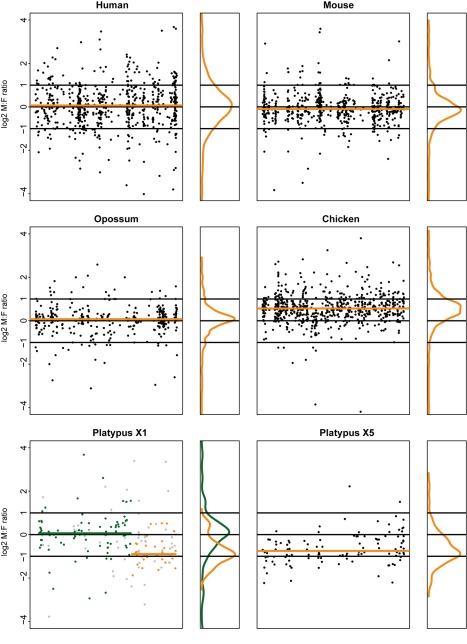
Male versus female expression levels of individual sex chromosomal genes in cerebellum from representative amniotes.Male to female (M∶F) gene expression ratios are plotted for individual genes (expressed in both sexes) on the human, mouse, and opossum X, platypus X1 and X5, and chicken Z chromosome for a representative tissue (cerebellum). Values are plotted on a log2 scale to allow for linear and symmetrical patterns (e.g., 0.5 [log2 ratio of −1]; 1 [log2 ratio of 0]; and 2 [log2 ratio of 1]). Median M∶F ratios for human, mouse, and opossum X, platypus X5 and X1 non-pseudoautosomal region, and chicken Z are indicated by orange lines. The distribution of individual M∶F ratios (orange vertical plots) is shown to the right of each main plot. Expression ratios of individual genes on the platypus X1 chromosome are indicated by green circles (pseudoautosomal genes with 1∶1 orthologs on chicken Chromosomes Z, 3, or 13; see [3] for details), orange circles (non-pseudoautosomal/sex-linked genes with 1∶1 orthologs on chicken Chromosome 12 [3]), or grey circles (pseudoautosomal or non-pseudoautosomal genes without clear 1∶1 chicken orthologs). Note that the respective medians for the platypus X1 were calculated on the basis of genes with chicken 1∶1 orthologs, although the other genes in these regions show very similar patterns. See Table S3 for platypus X1 M∶F ratios for all six organs.